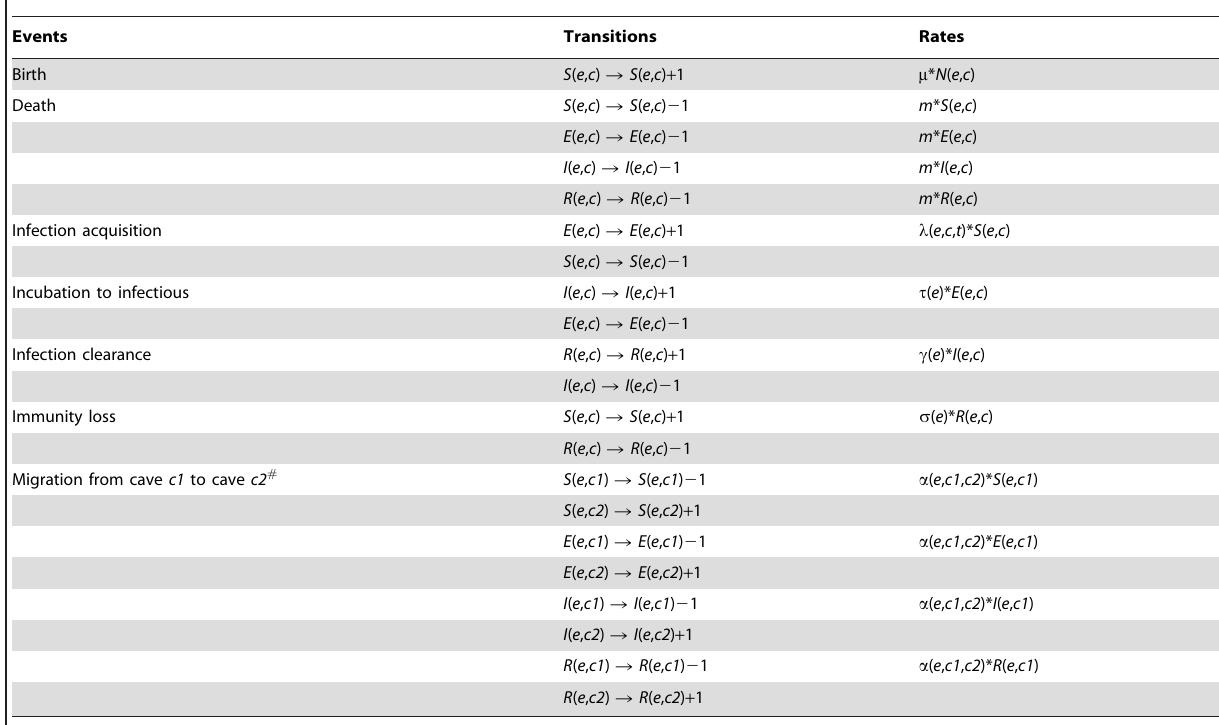
Table 3. Model description.